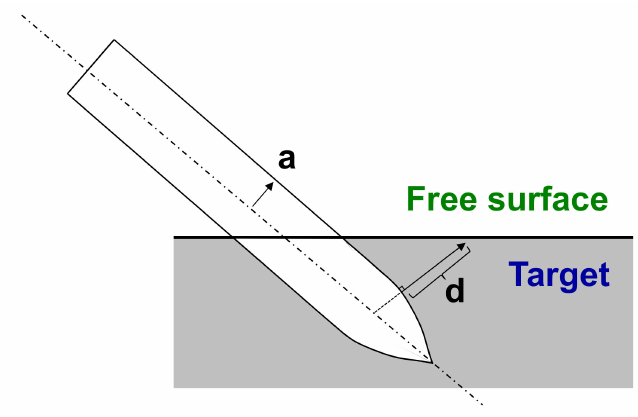
Figure 4. Schematic figure describing the free surface e ff